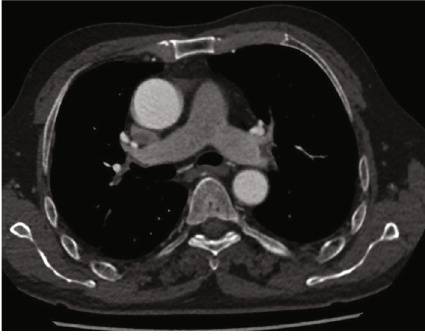
Figure 6: Computed tomography angiography (CTA) showed pulmonary embolism disappearance in the second